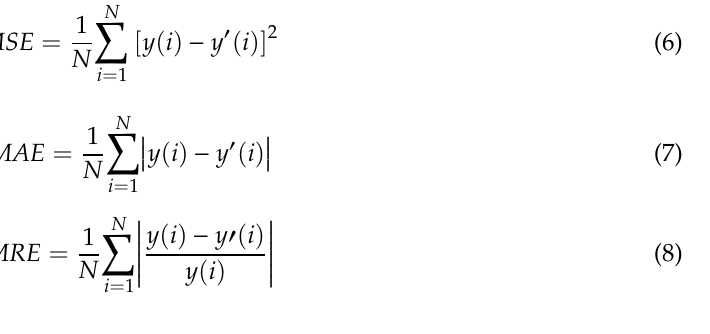
Figure 5. Schematic diagram of the foundation pit shape and surrounding environment. 3. Results and Discussion 3.1. Decomposition of Deformation Data We selected four representative monitoring points—KD25, KD62, ZD13, and ZD14 —as targets. Both KD and ZD are the names of the monitoring points. Among them, those starting with KD are all settlement monitoring points, while those starting with ZD are all horizontal displacement monitoring points. KD25 and KD62 were the surface settlement monitoring points located in the middle of the foundation pit and the outer ring side, respectively. ZD13 and ZD49 were the surface horizontal displacement monitoring points located in the middle of the foundation pit and the outer ring side, respectively. We selected these four consecutive 90 periods for field monitoring data. The date range of the applied data was from 26 August 2018 to 17 August 2019. The deformation duration curve of the four points is shown in Figure 6.